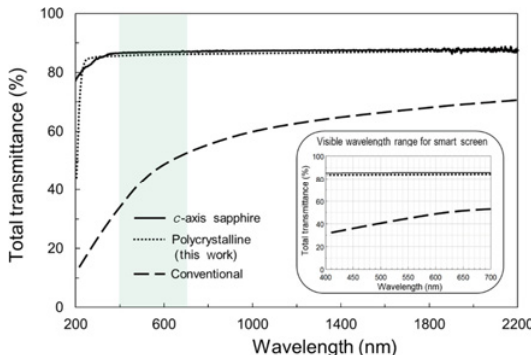
Fig. 2 Total transmittance spectra of c -axis sapphire single crystals and conventional and advanced alumina ceramics in a wavelength range of 200–2200 nm. The inset shows the comparative data magnified in visible wavelength range mostly used in